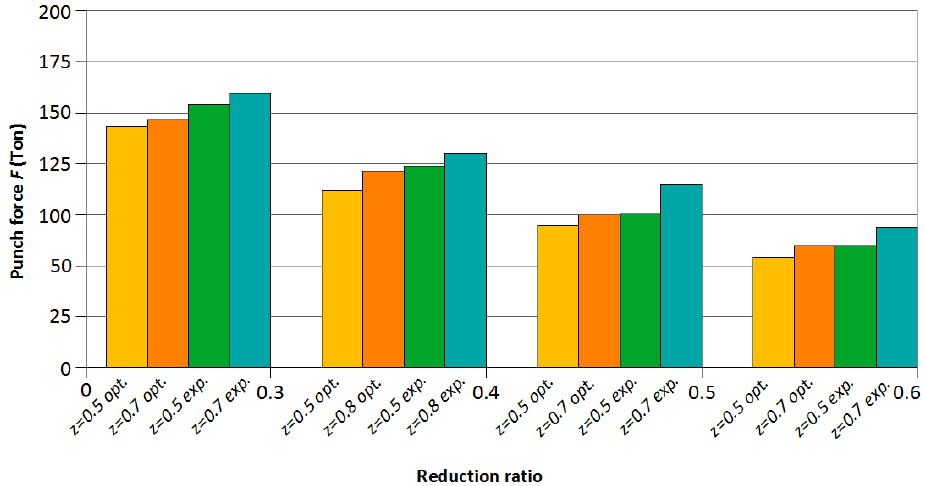
Figure 19. Variation between optimal and experimental values of punch force at different reduction ratios.